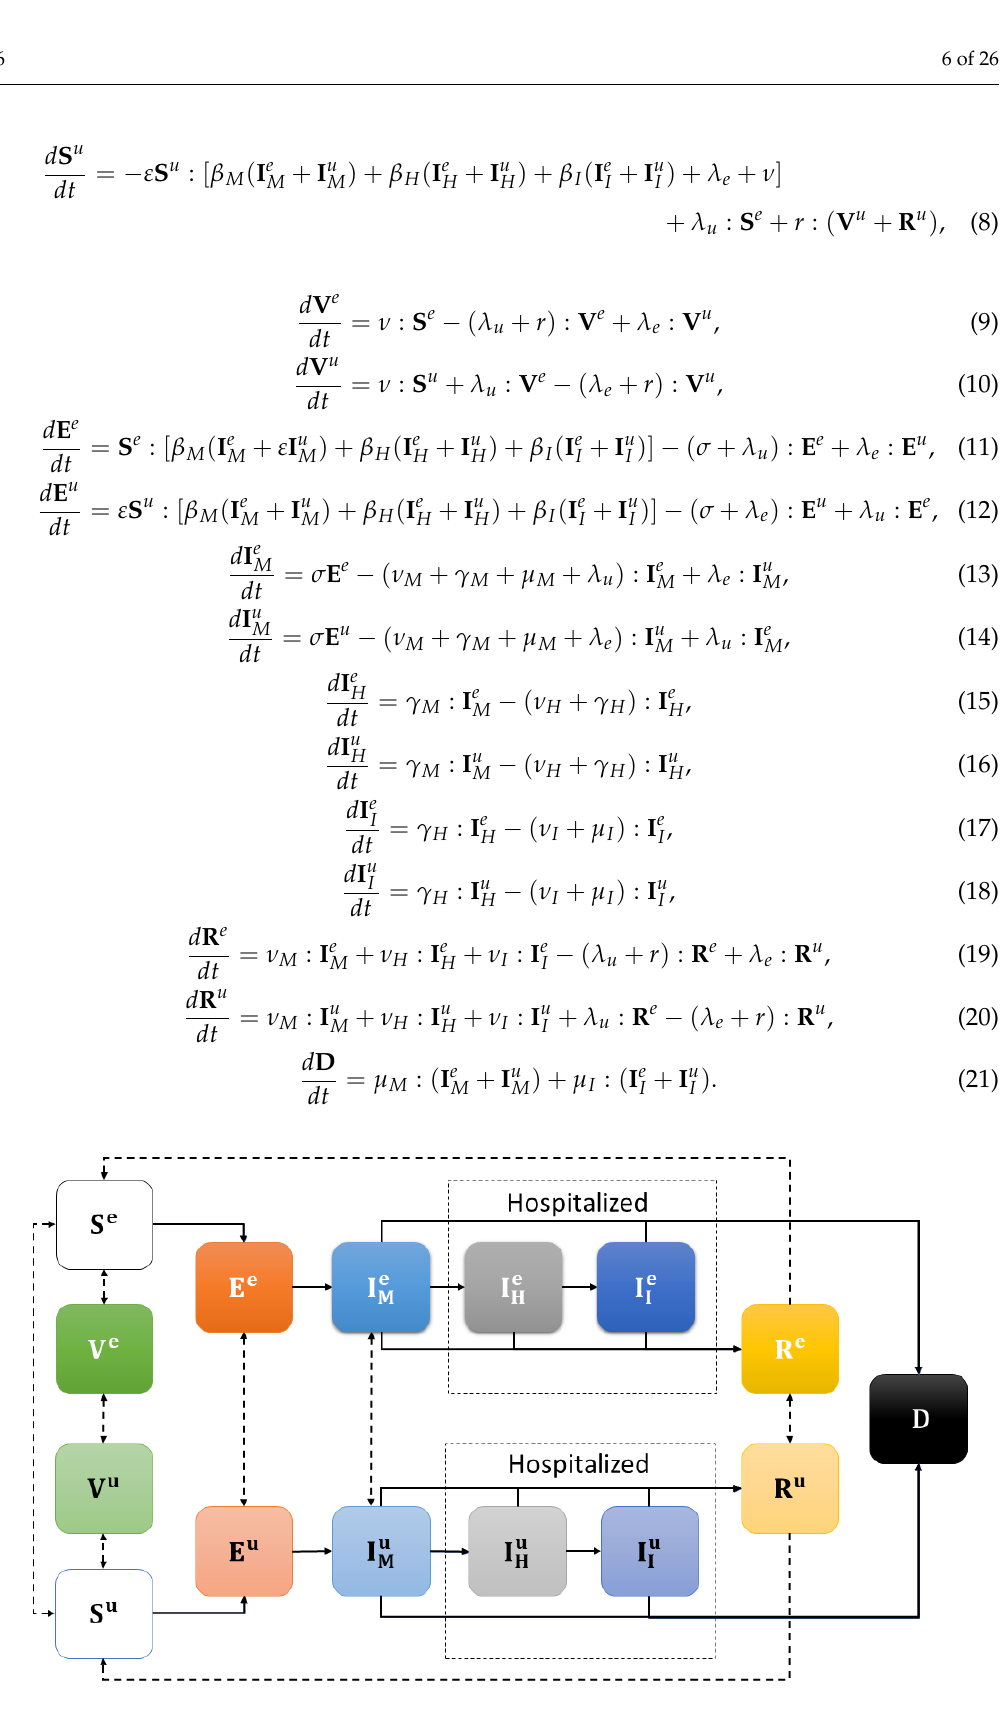
Figure 1. Schematic representation of the SEIR-type model in Equations (7)–(21). The matrices β M , β H , and β I are the transmission parameters for the mildly ill, hos- pitalized, and in intensive care infective classes, respectively, taking into account the age group and location for each class. More specifically, β M , β H , and β I are